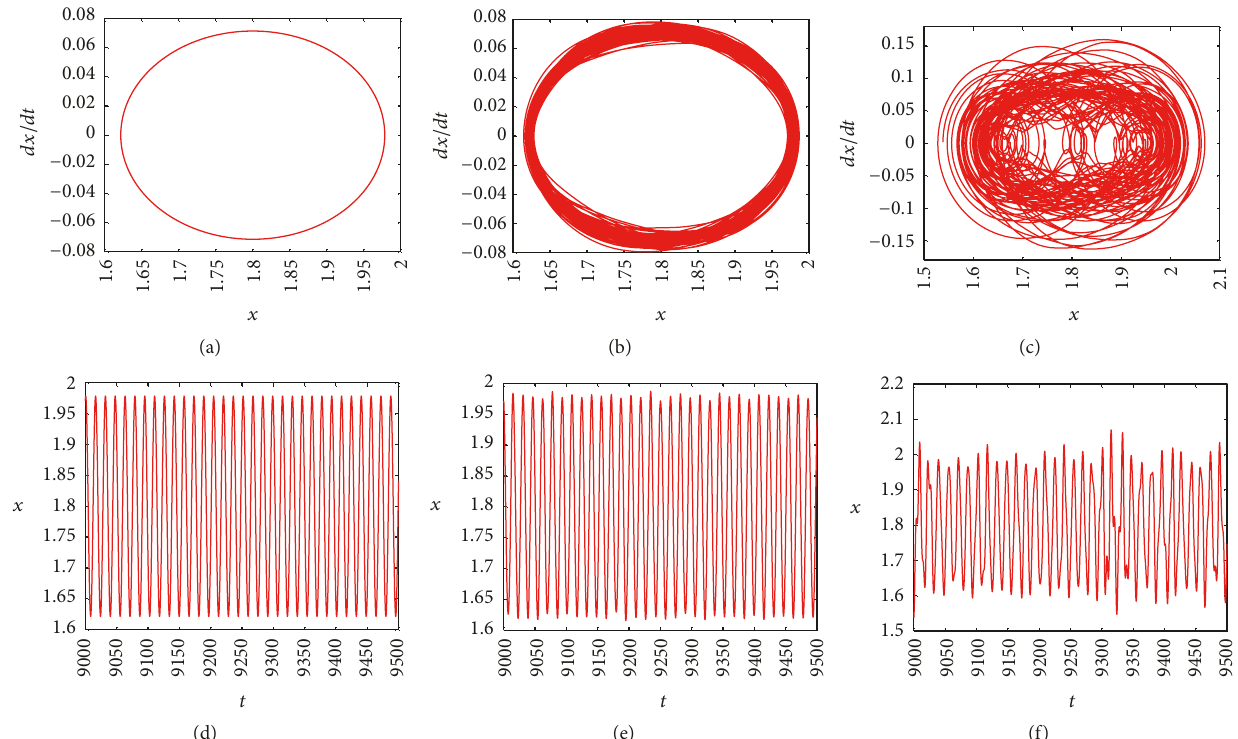
Figure 11: Phase portraits and time histories of the DPWS system under the parameters Ω = 0.4 ; 𝜏 = 𝜋/2 ; 𝑓 = 0.15 . (a) Phase portraits for 𝛾 = 0.0 ; (b) phase portraits for 𝛾 = 0.01 ; (c) phase portraits for 𝛾 = 0.1 ; (d) time histories for 𝛾 = 0.0 ; (e) time histories 𝛾 = 0.01 ; (f) time histories for 𝛾 = 0.1